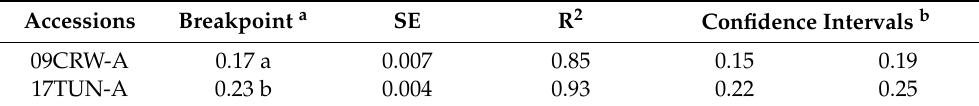
Table 1. Breakpoint (threshold value for the initiation of stomatal closure), standard error (SE), R 2 , and confidence intervals for the plateau regression analysis used to evaluate differences in drought tolerance between S -metolachlor-susceptible and -resistant Palmer amaranth ( Amaranthus palmeri (S.) Wats.) accessions subjected to progressive drought; greenhouse experiment conducted at the Shult Agricultural Research & Extension Center, University of Arkansas, Fayetteville, AR, USA, in 2021.